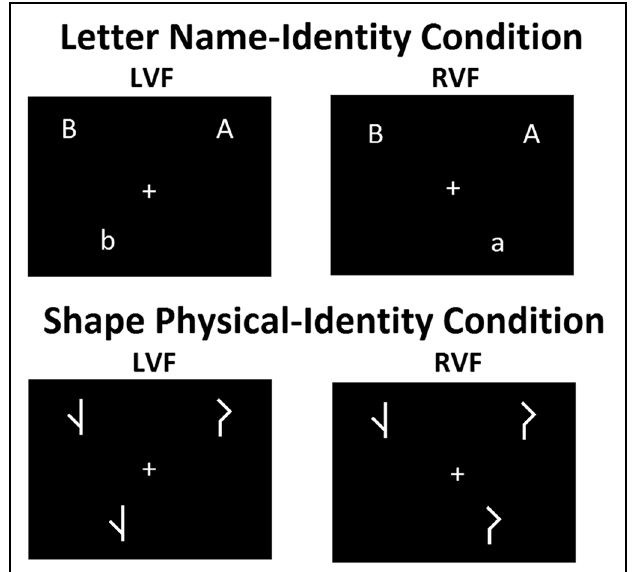
FIGURE 2 | Five shapes and their mirror shapes, each consists of three small connected lines of 2 mm long and line thickness of 2.25 point